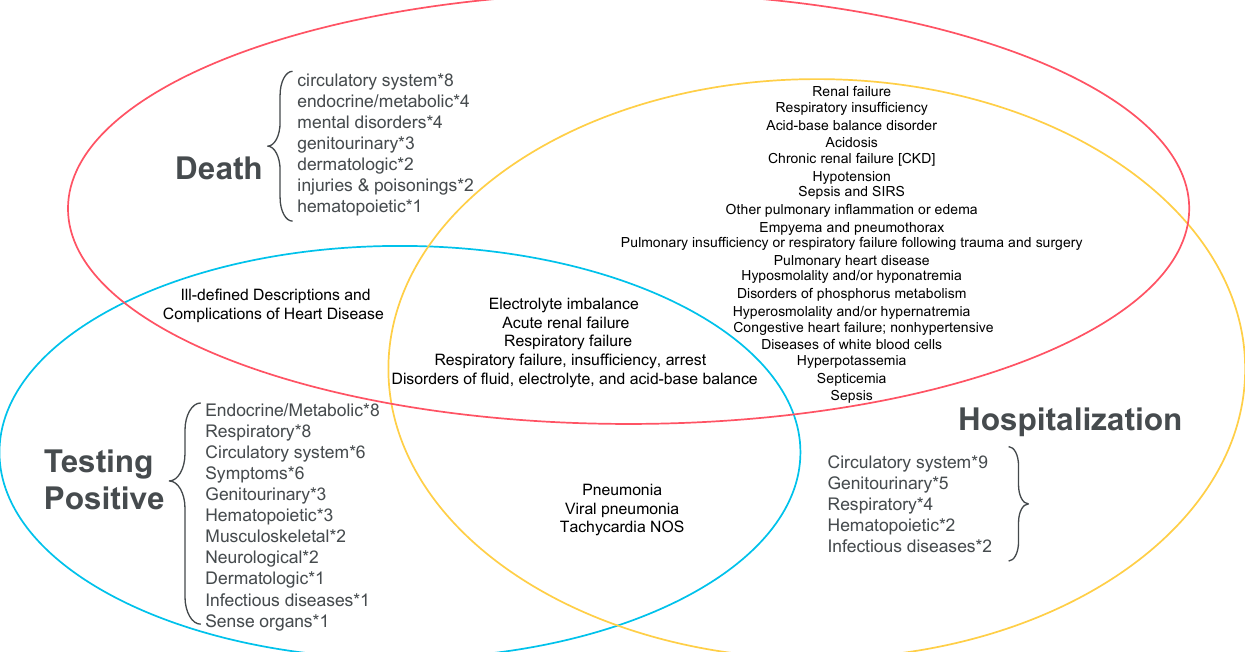
Figure 4. Venn diagrams of the top 50 traits. Each circle represents the top 50 hits from the full cohort PheWAS. Traits shared across PheWAS are stated, while the corresponding number of traits within a given disease category that are unique to that PheWAS are also provided. Abbreviations: NOS, not otherwise specified; SIRS, systemic inflammatory response syndrome